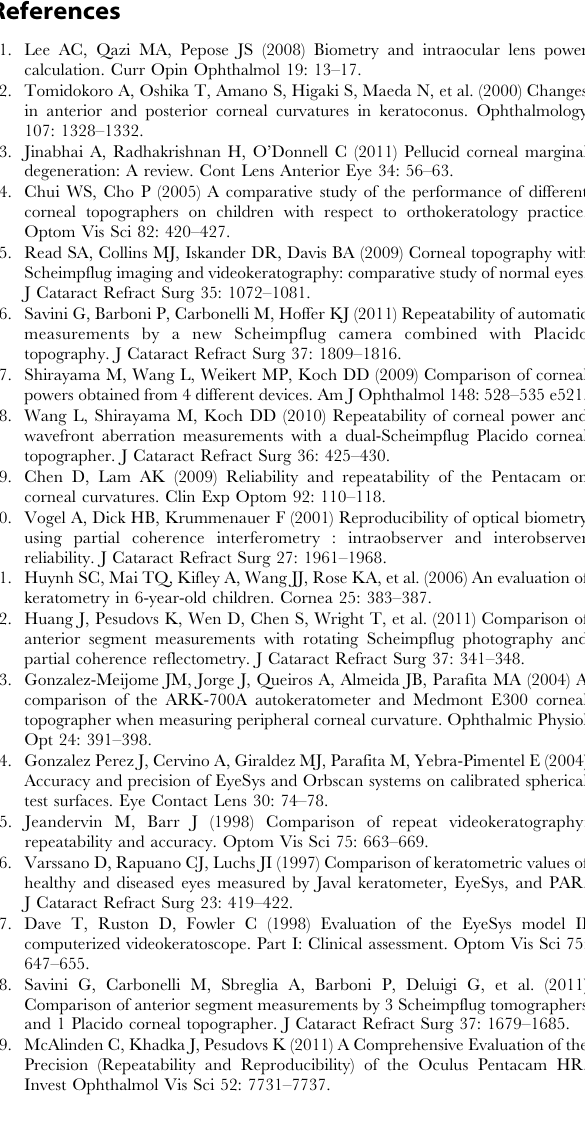
Table S8 Comparison of the vector J 0 between 8 Different Devices. Table S9 Comparison of the vector J 45 between 8 Different